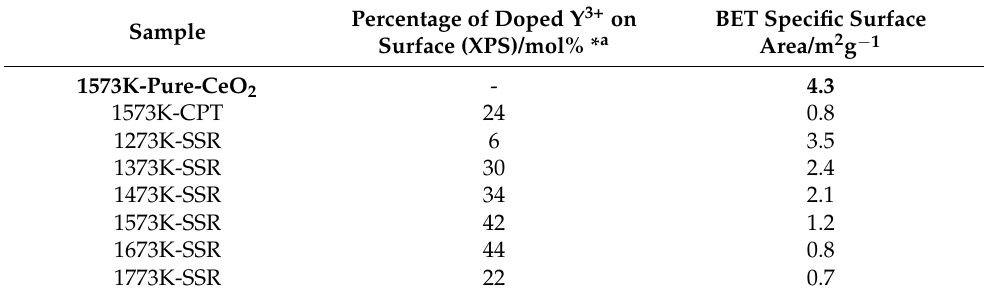
Table 2. Y 3+ doping concentration on the surface and specific surface area.